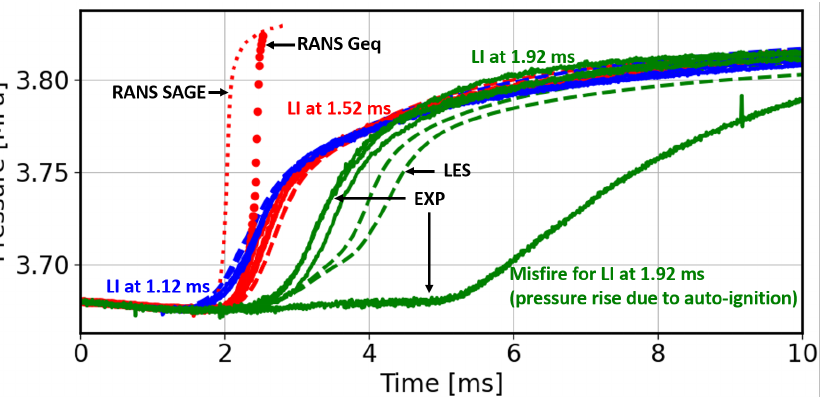
Figure 6. Pressure rise in the vessel after ignition at 1.12, 1.52, and 1.92 ms for different realizations. The solid lines show the experiments while the dashed lines indicate the LES. The pressure rise for the two RANS simulations are illustrated with the circular symbols (only for ignition at 1.52 ms).